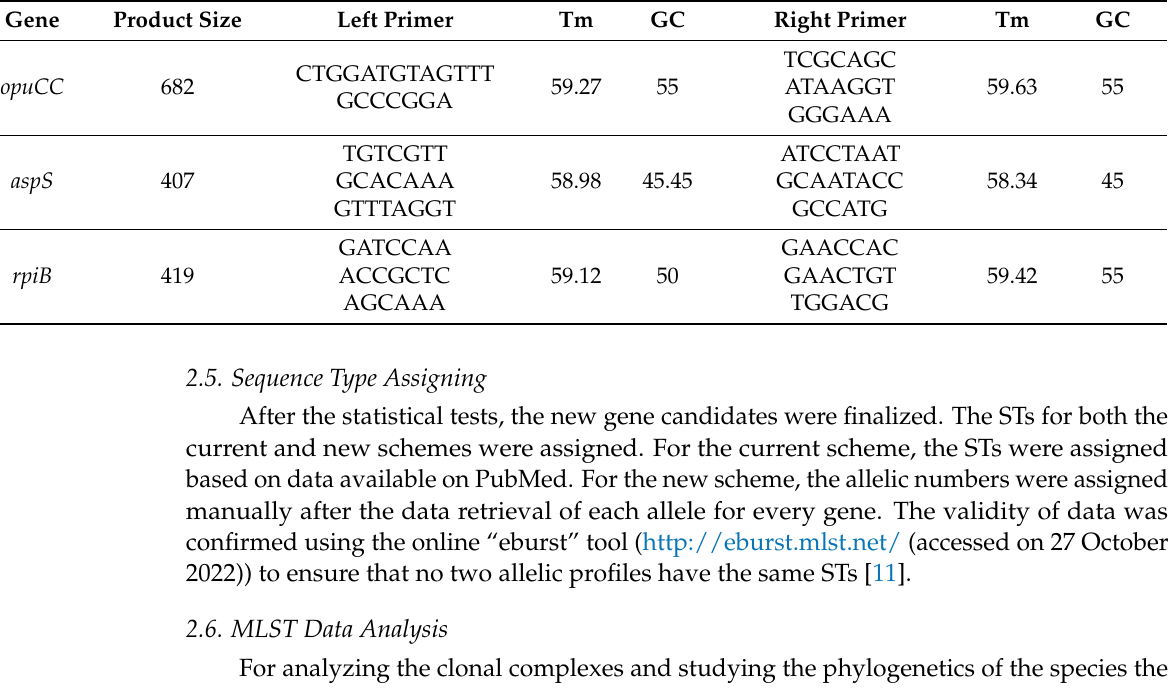
Table 1. Primers for the proposed gene candidates. The table provides the details of the primers and their properties based on which they were selected for the proposed gene